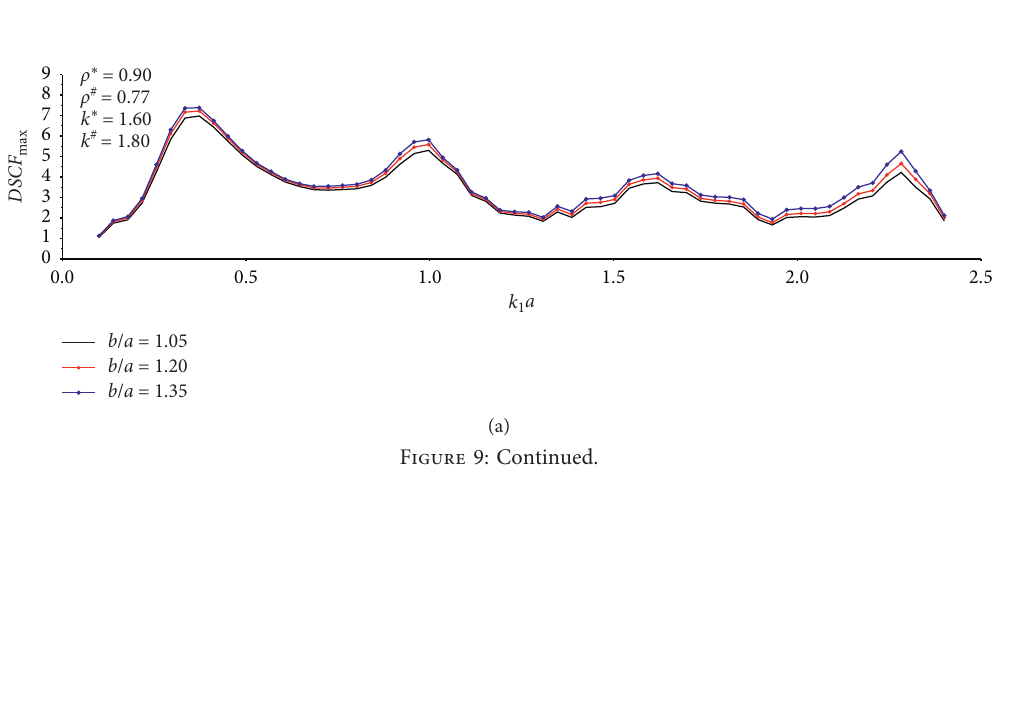
Figure 8: DSCF of linings composed of grade Q345 steel for geological Condition A. (a) Condition A-Q345: inner surface. (b) Condition A- Q345: outer